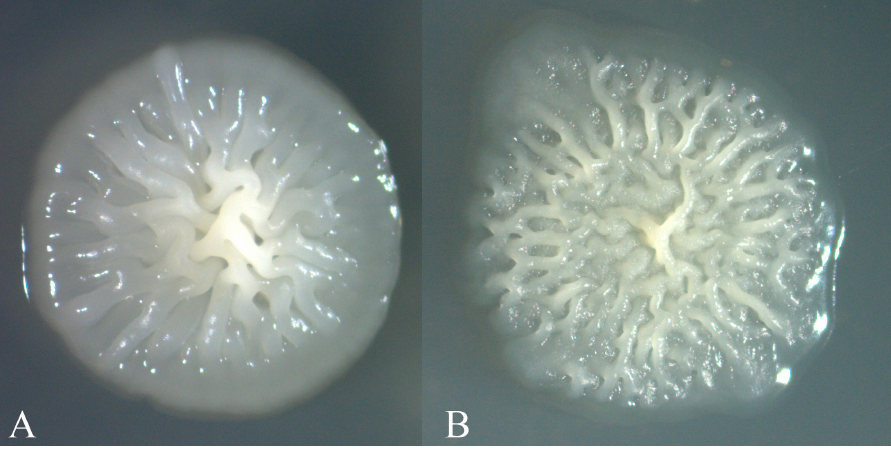
Figure 2. Morphology of the Bacillus genus colonies. A – the novel strain of B. pumilus (16). B – the B. subtilis B-1323